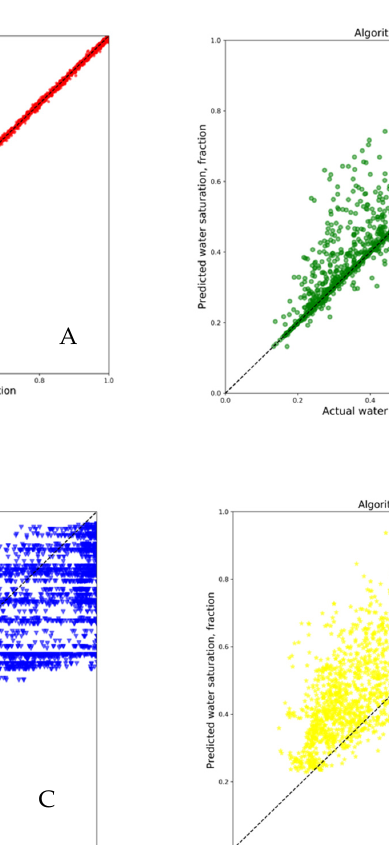
Figure 9. Evaluation metrics for dataset B where PEF log has not been used for analysis in the algorithms where it’s found that Super Learner is generating best results compared to other methods.